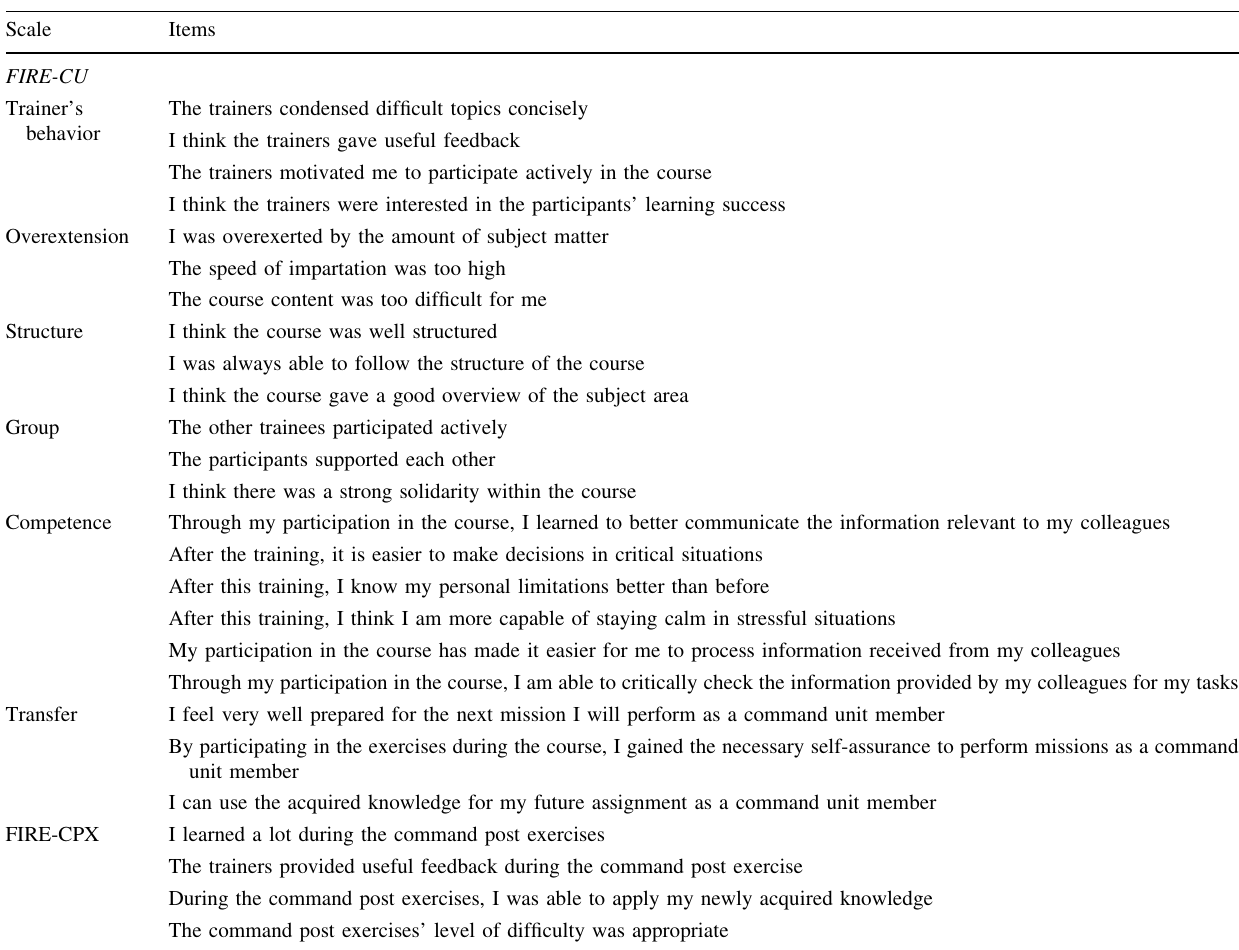
Table 1 Final FIRE-CU and FIRE-CPX items Scale Items FIRE-CU Trainer’s